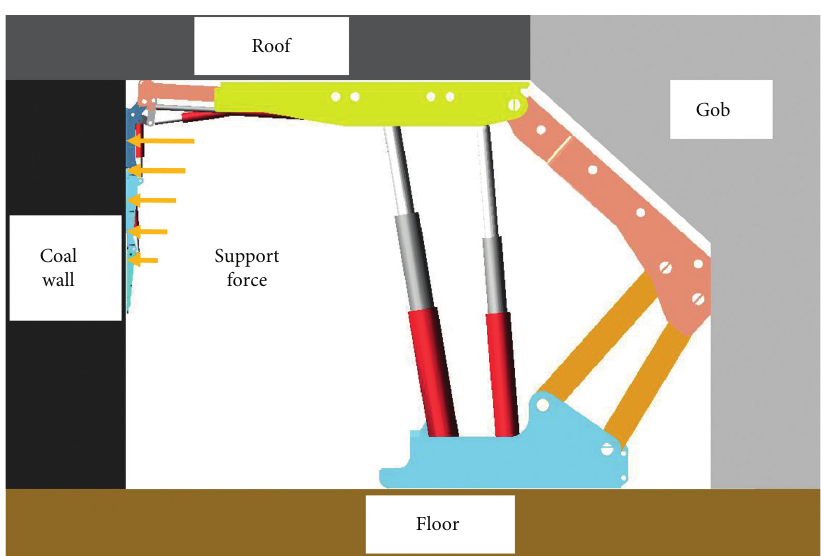
Figure 1: Schematic of the coal wall supported by the hydraulic support.